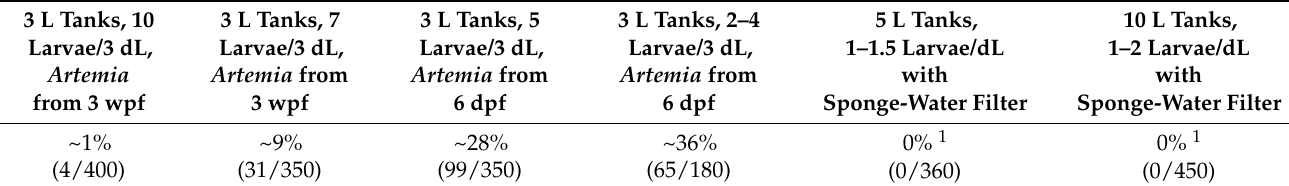
Table 2. Survival of paradise fish larvae is dependent on stocking densities and feeding regime (survival shown as the percentage of the number of individuals reaching adulthood compared to the total number of larvae at the beginning of the respective rearing